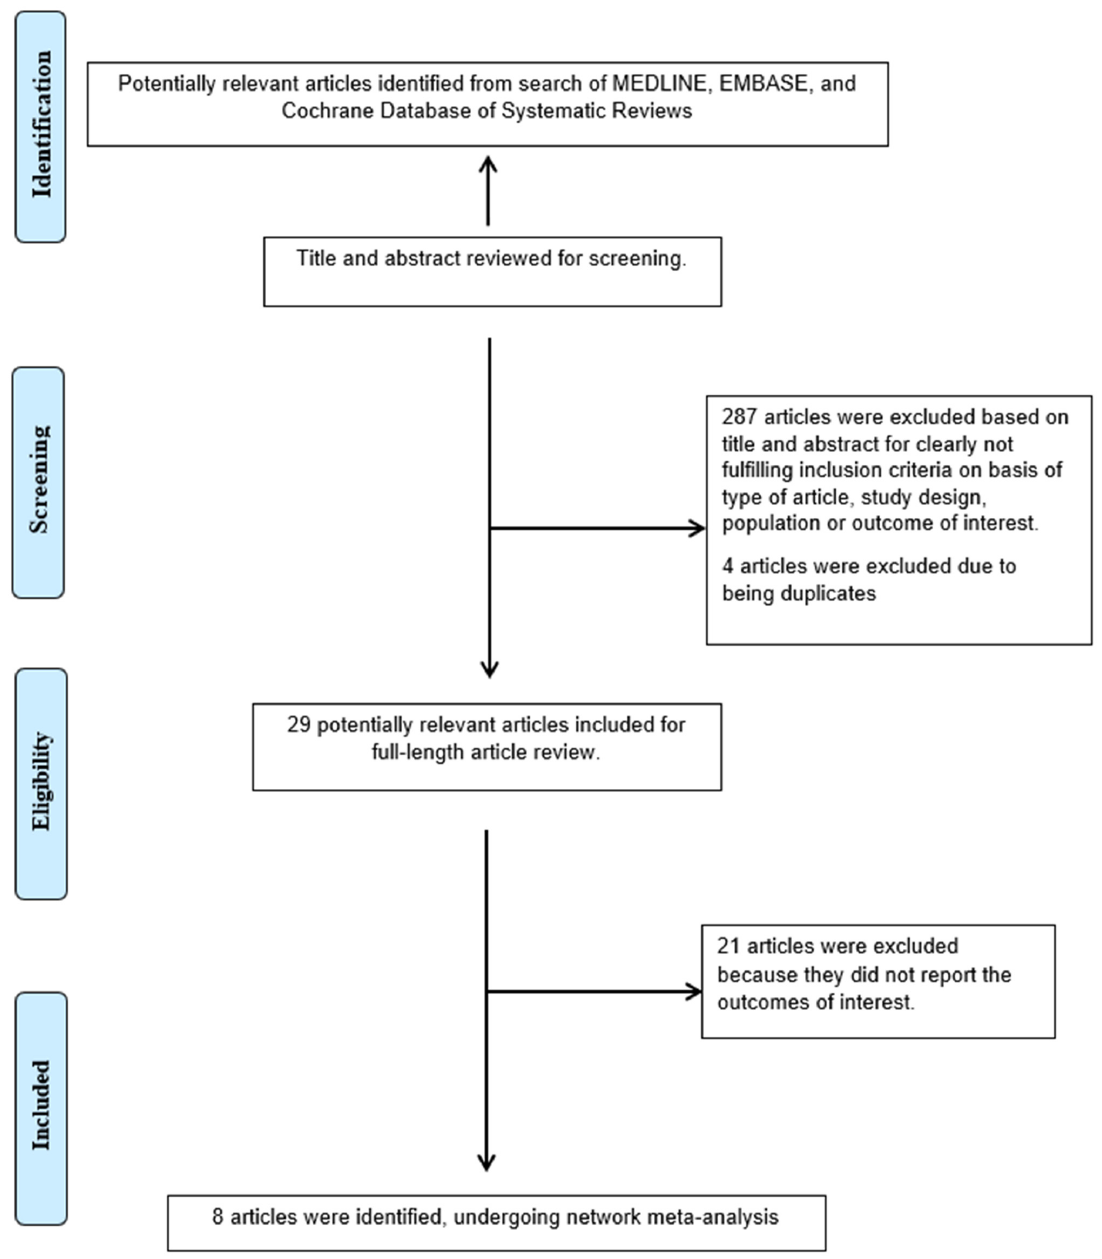
Figure 1. Outline of our search methodology.